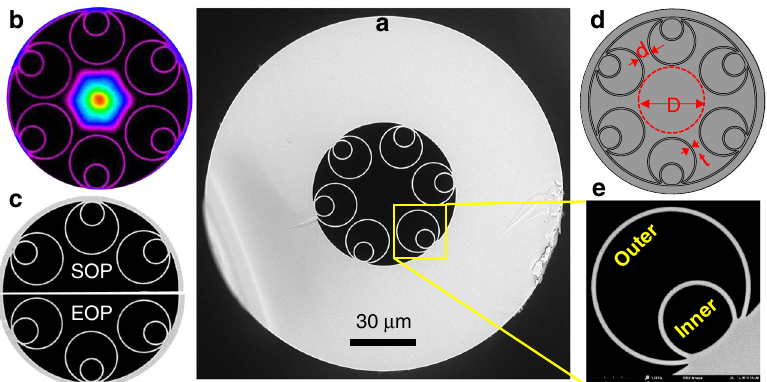
Fig. 1 Nested Anti-resonant Nodeless Fibre (NANF). a scanning electron micrograph cross-section of a typical fabricated hollow-core NANF. b microscope image of the transmitted optical mode, con fi ned in the air core surrounded by the 6 nested tubes. c comparison between the start of pull (SOP) and end of pull (EOP) cross-sections of the fi bre, showing the uniformity achieved along the as-drawn fi bre length . d and e illustrate the terms used in de fi ning the structure.